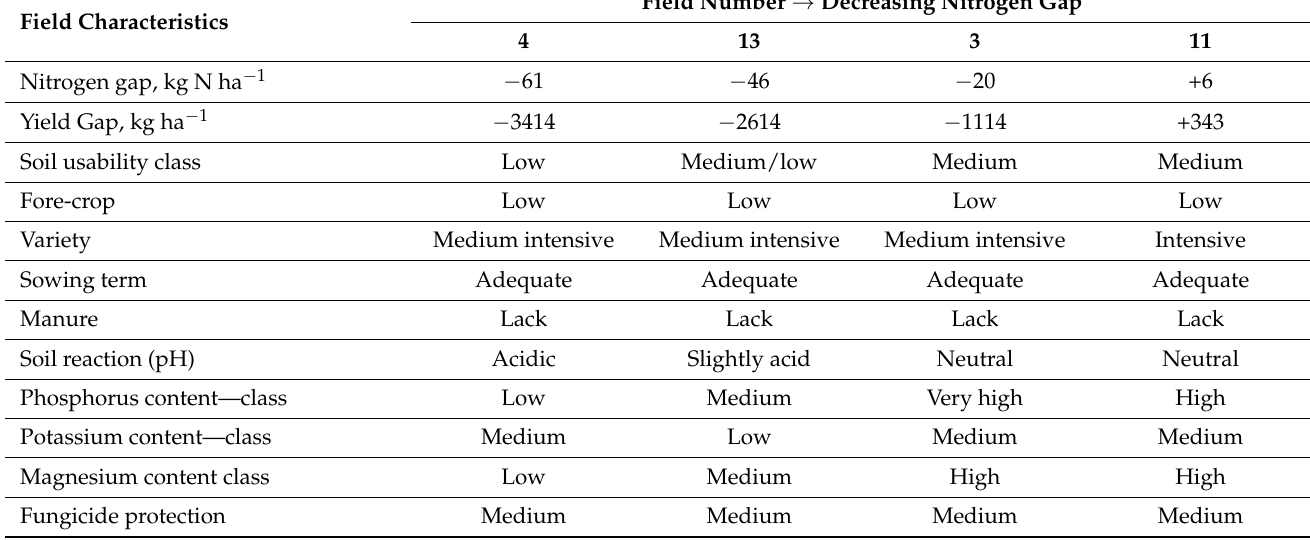
Table A1. A detailed analysis and evaluation of the agronomic factors responsible for the NG appearance in Figure